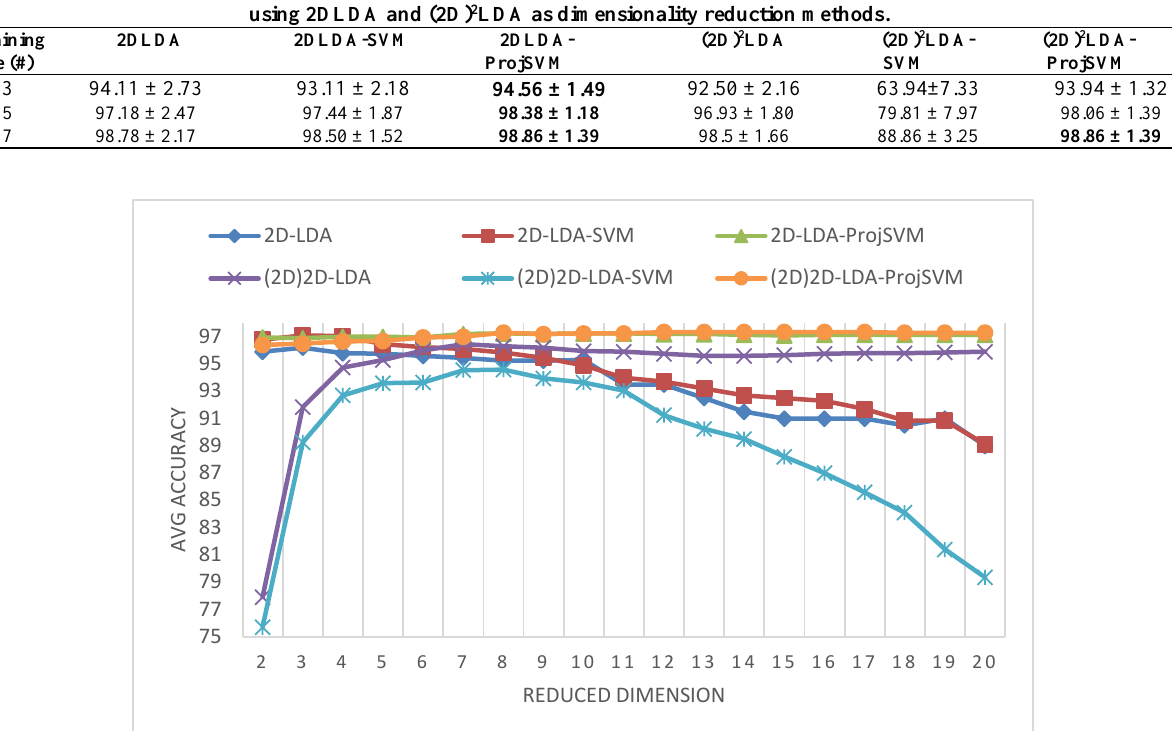
Figure 3. Average accuracy versus reduced dimension for six methods on ORL dataset with LDA-based